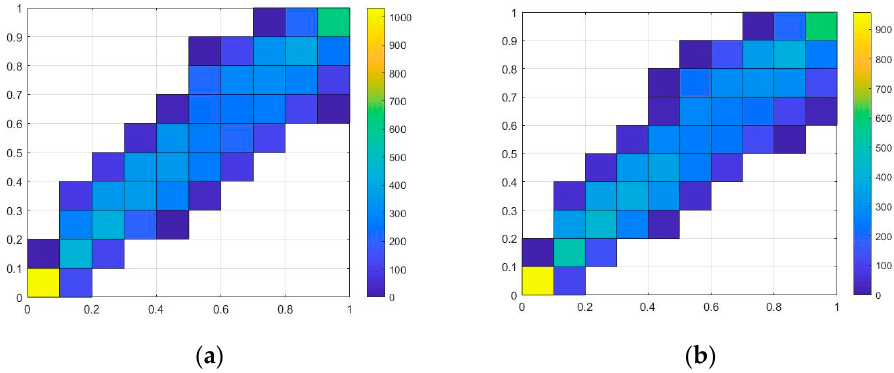
Figure 6. Binary histograms of reliability values: ( a ) Machine pair 5–6; ( b ) Machine pair 7–8.